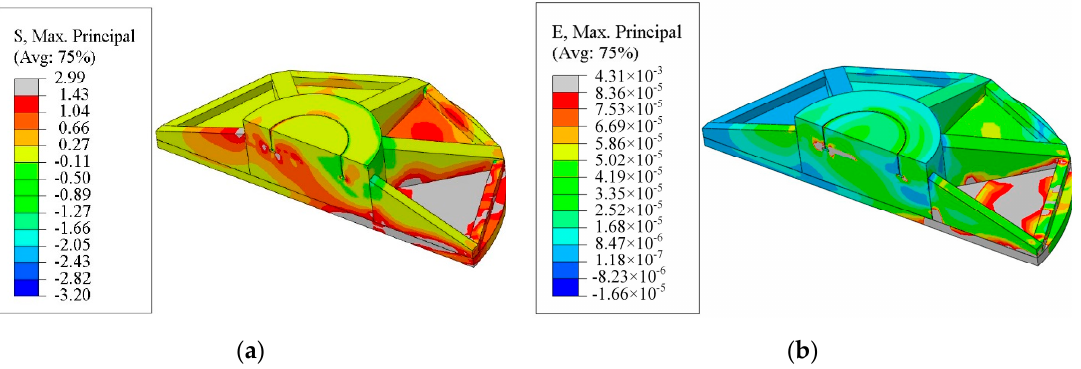
Figure 9. Maximum principal stress and strain of foundation concrete after strengthening under the extreme load case. ( a ) Maximum principal stress; ( b ) Maximum principal strain.